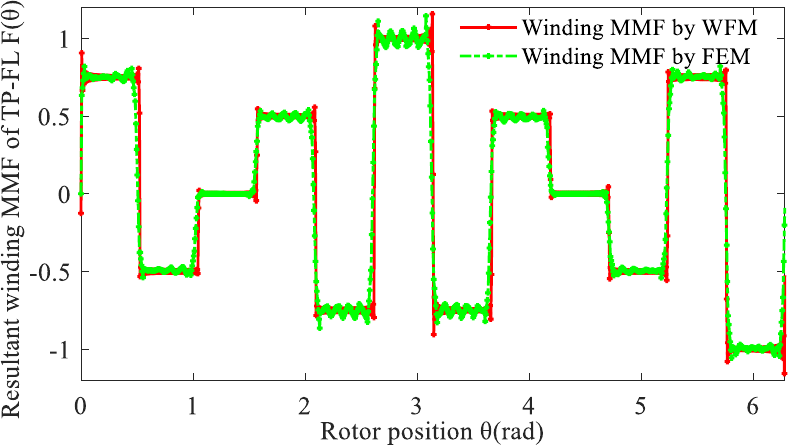
Figure 8. Resultant winding MMF of 12-slot/10-pole TP-FL winding at time t = 1.67 × 10 −3 s. Similarly, for a 12-slot/10-pole TP-FL winding, resultant winding MMFs F ( θ , t ) are given by winding function method as shown in Figure 9.